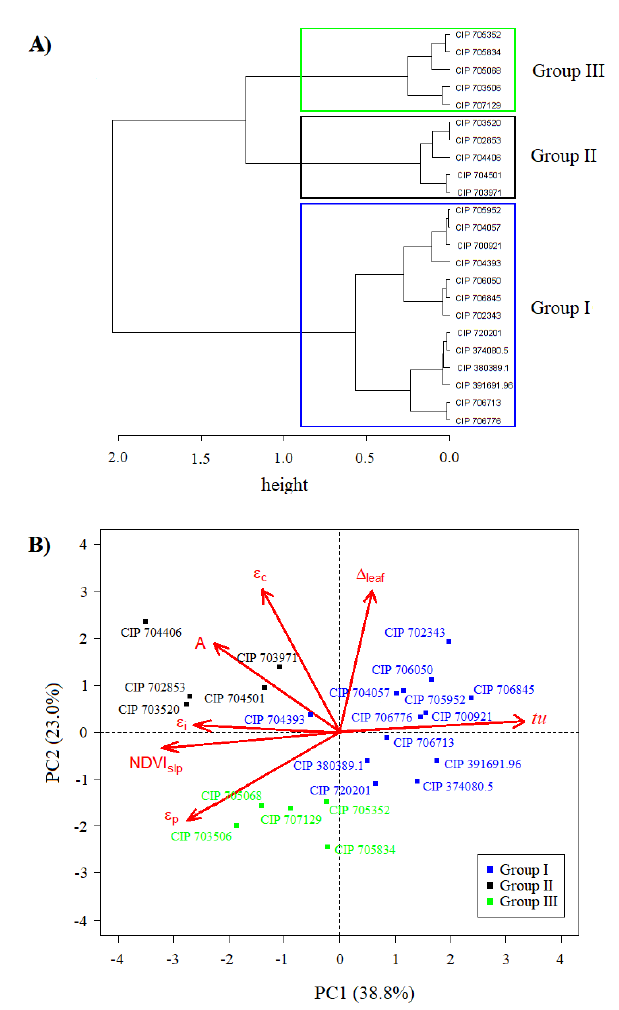
Figure 2. Hierarchical clustering using Ward’s method ( A ). Accessions ordination based on principal component analysis for physiological ( A , ∆ leaf ), radiation-related ( ε i , ε c , ε p ), senescence delay ( NDVI slp ) and tuberization precocity ( tu ) parameters ( B ). See abbreviations in Table